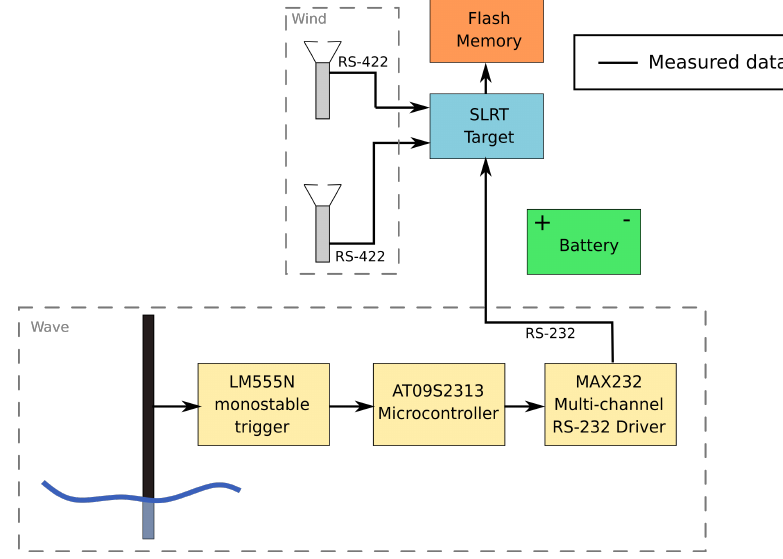
Figure 5. Block diagram of the measurement hardware